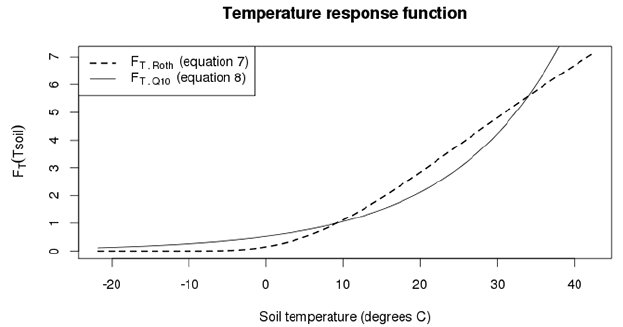
Figure 1. The temperature response curves [ F T (T soil ) ] from Eqs. (7) and